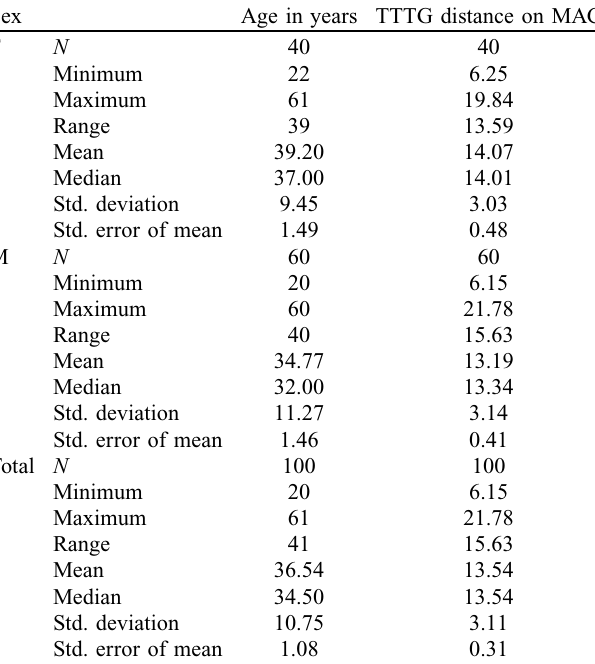
Table 1. Age and TTTG distance